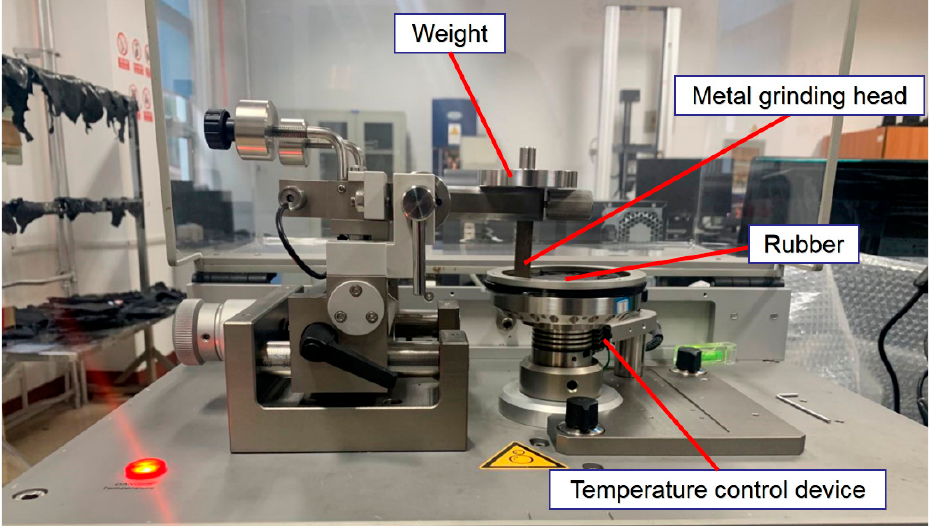
Figure 4. CSM friction and wear